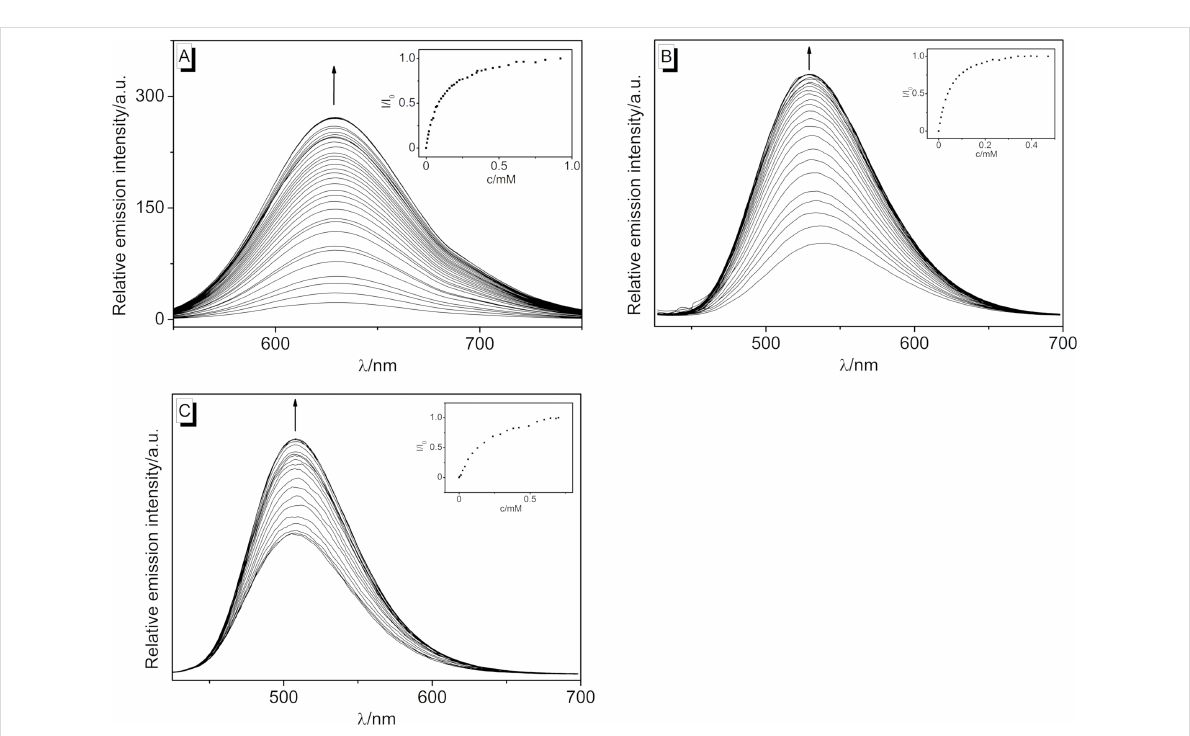
Figure 3: Spectrofluorimetric titration upon the addition of ct DNA to the styrylquinolizinium derivatives 3a (A), 3b (B) and 3c (C) in BPE buffer [ c L = 5 µM (A, C), c L = 1 µM (B), c DNA = 1.45 mM, c DNA in base pairs]. The insets show the plots of relative emission intensity vs DNA concentration. The arrows indicate the changes of emission intensity upon the addition of ct